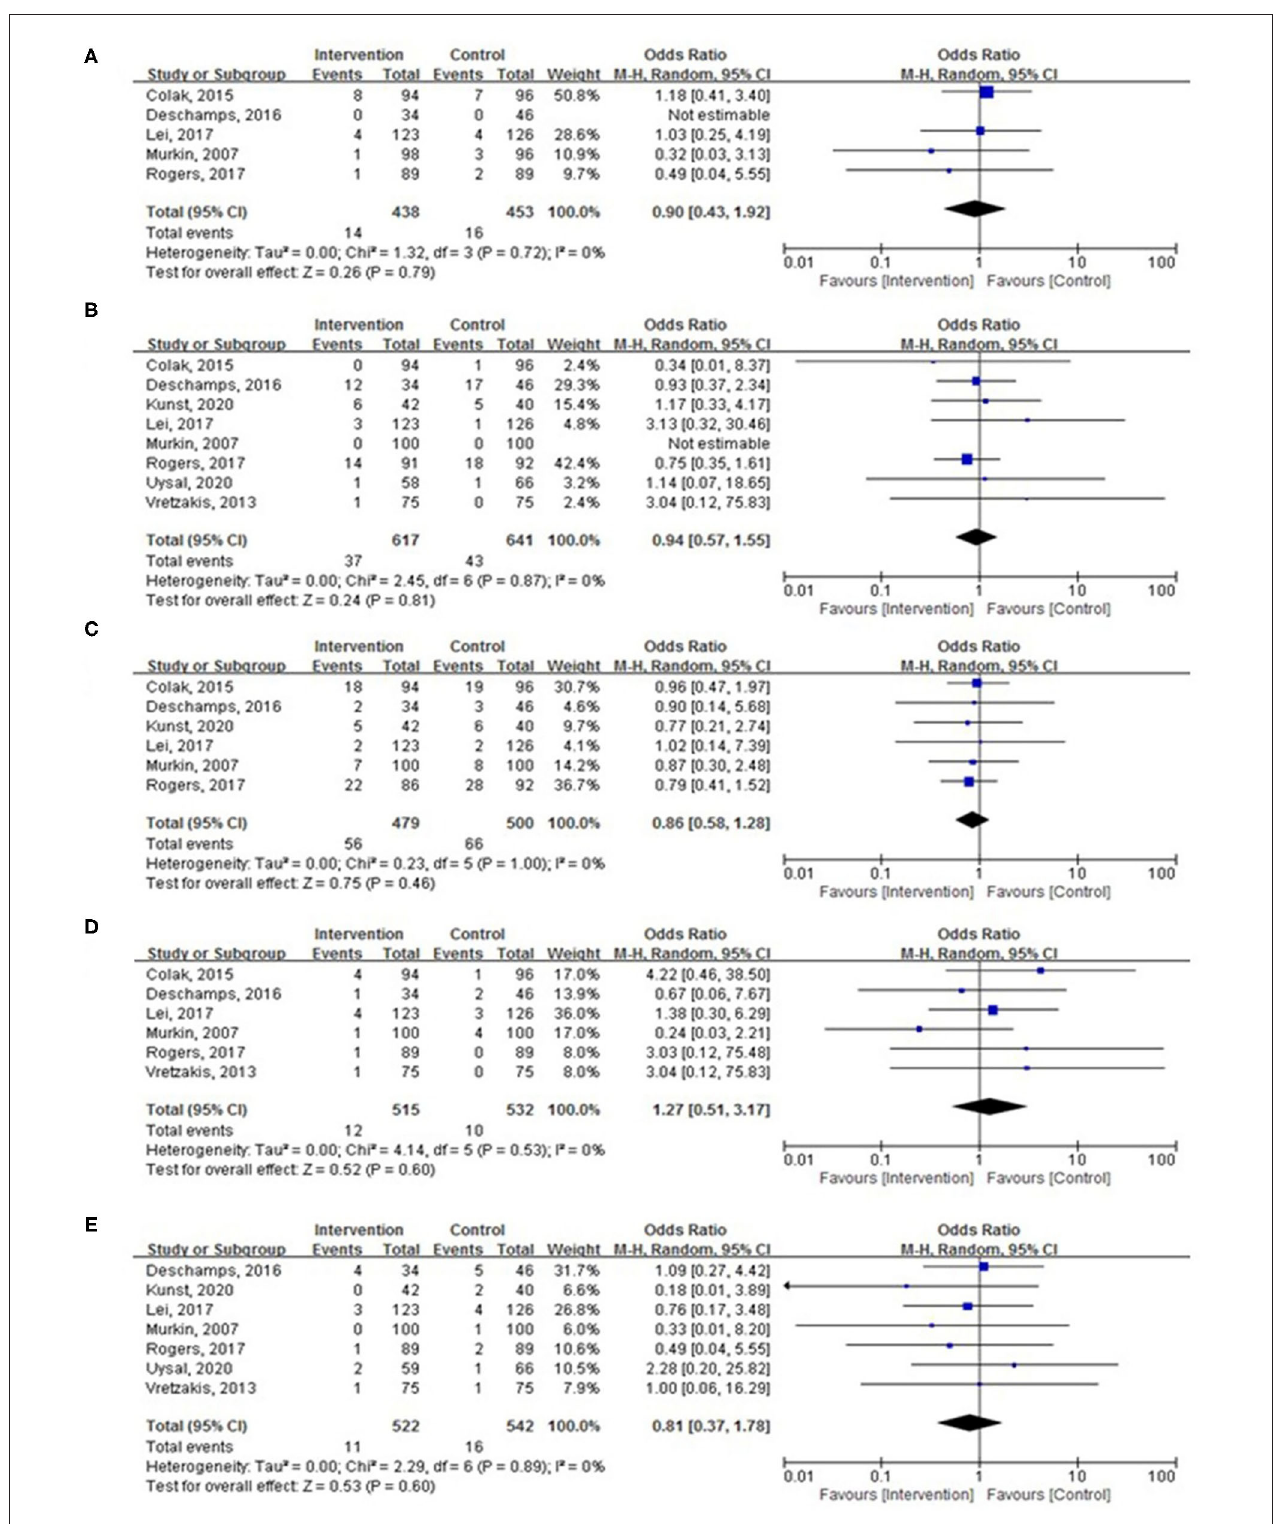
FIGURE 6 | The pooled effect of cerebral oximetry monitoring-guided intervention on the incidence of (A) myocardial infarction (MI), (B) acute kidney injury (AKI), (C) surgical site infection, (D) cerebrovascular accident (CVA), and (E) hospital mortality.